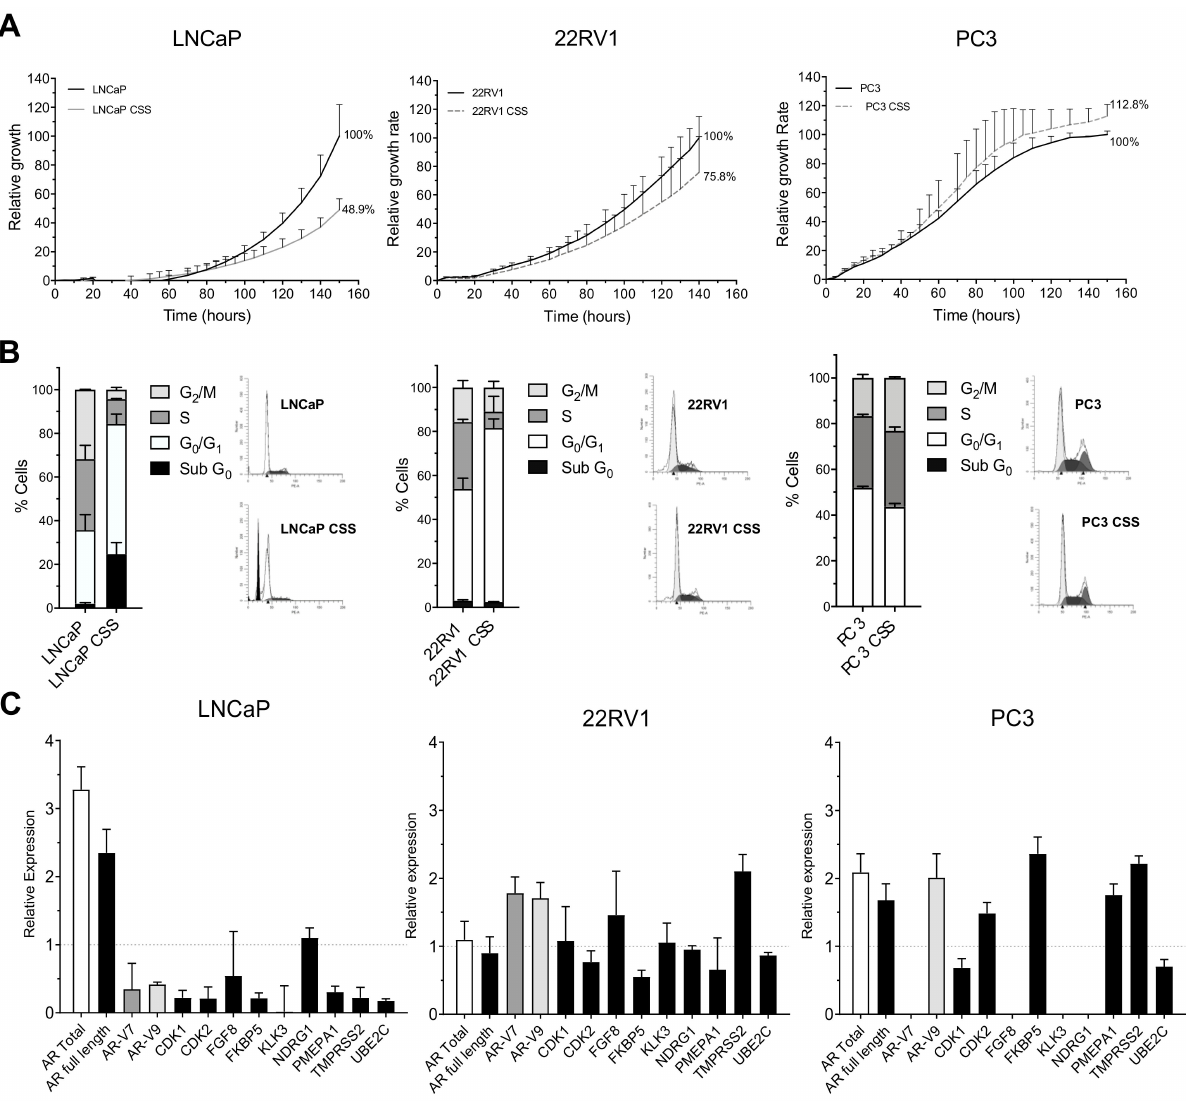
Figure 1. Response to hormonal suppression (ADT) in wild-type PCa cell lines cultured with regular medium or hormone- reduced medium (CSS) for 5 days. ( A ) Analysis of cell proliferation using xCELLigence. Results are normalized considering the final value for control cultures 100%. Data shown correspond to the mean ± SD calculated from triplicates for each condition. ( B ) Cell cycle analysis after 5 days ADT treatment. Bar graphs represent the percentages corresponding to each of the phases of the cell cycle in the different study groups; the error bar corresponds to the SD calculated from the three replicas for each condition. ( C ) Relative expression of androgen receptor ( AR ) isoforms and AR target genes. The results are shown after normalization with respect to endogenous control (GADPH) and referenced to wild-type cell lines grown in regular fetal bovine serum (FBS). The error bars shown correspond to the SD calculated from the